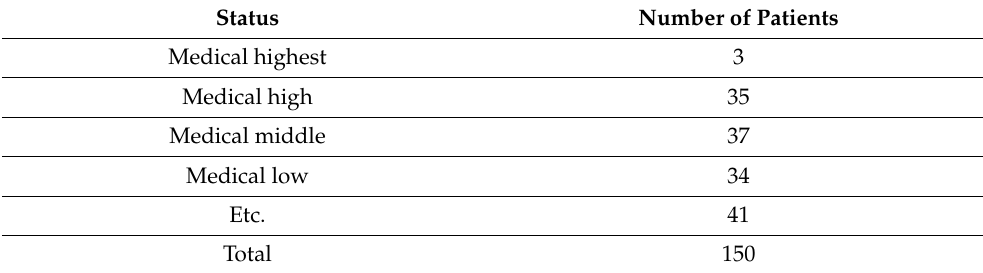
Table 4. Number of patients according to egress type.